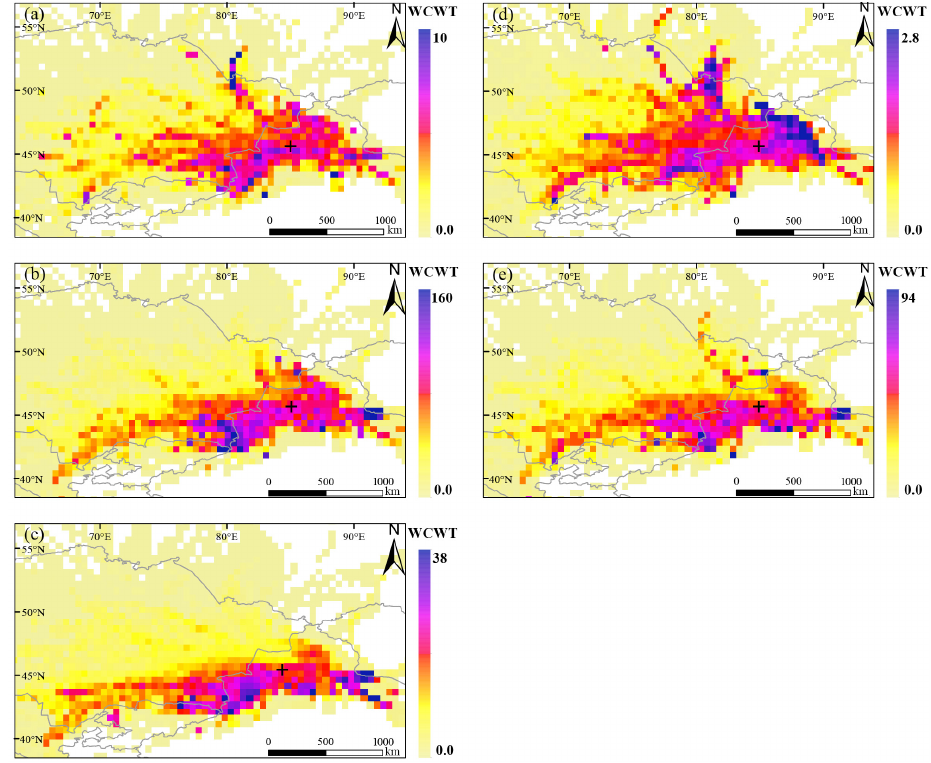
Figure 16. Annual weight concentration-weighted trajectory (WCWT) maps for five identified sources derived from PMF analysis including